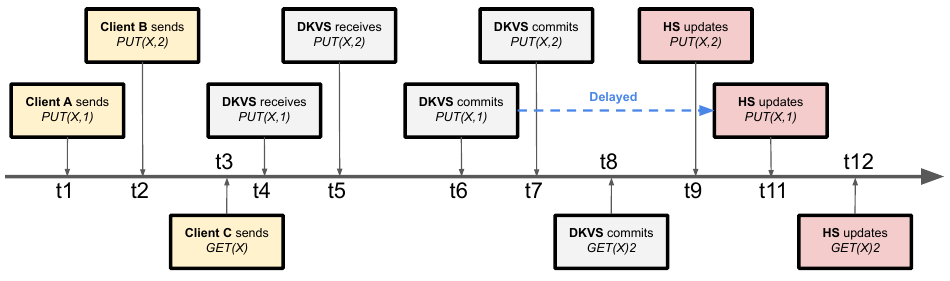
Figure 3. History Updates Out-of-Order Example.